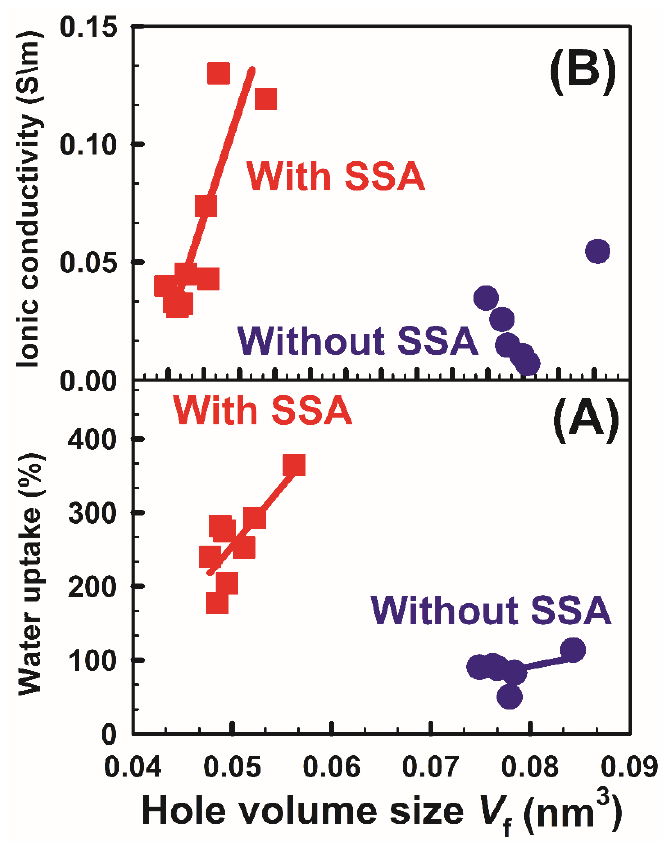
Figure 11. The correlation between the hole volume size V f and both ( A ) water uptake and ( B ) ionic conductivity for samples without and with SSA.